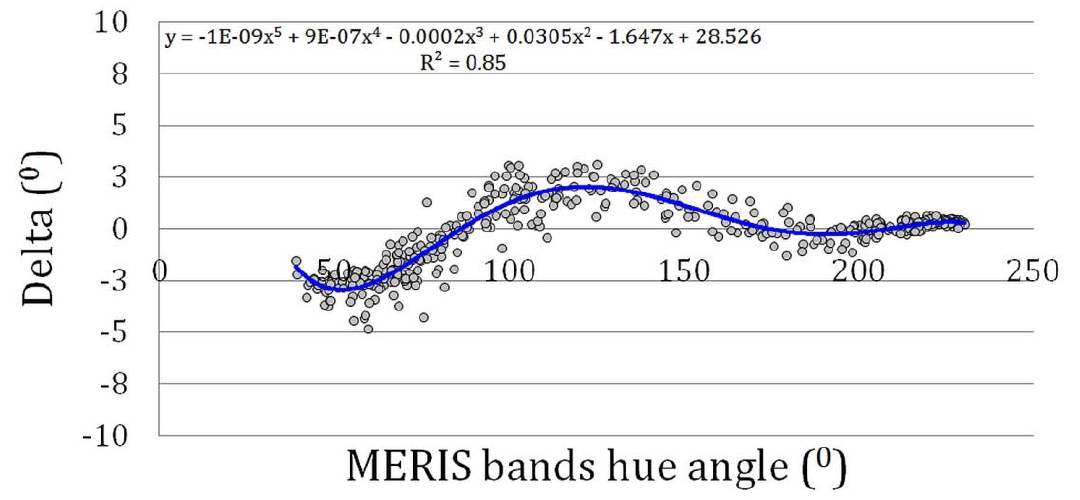
Figure 5. Deviation delta (°) from the hyperspectral hue angle as function of the MERIS hue angle derived from the linear satellite band